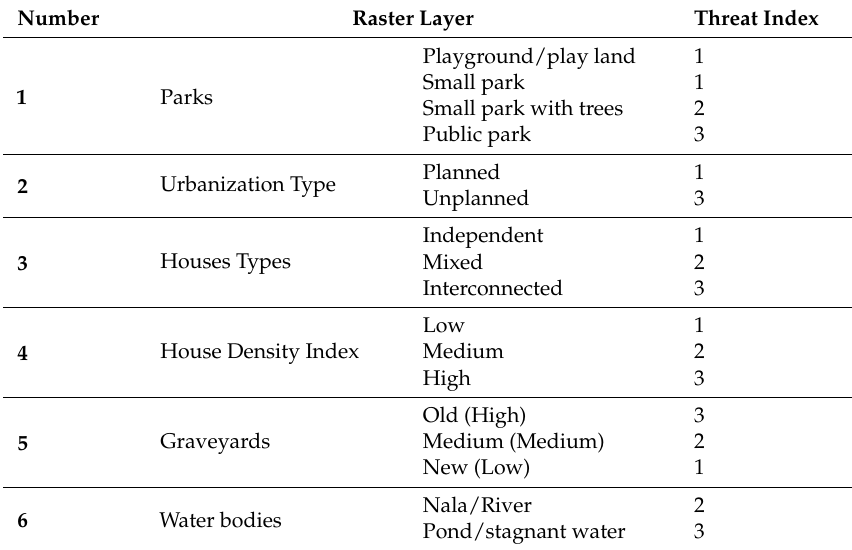
Table 4. DF raster input layers and their respective weight value [45].